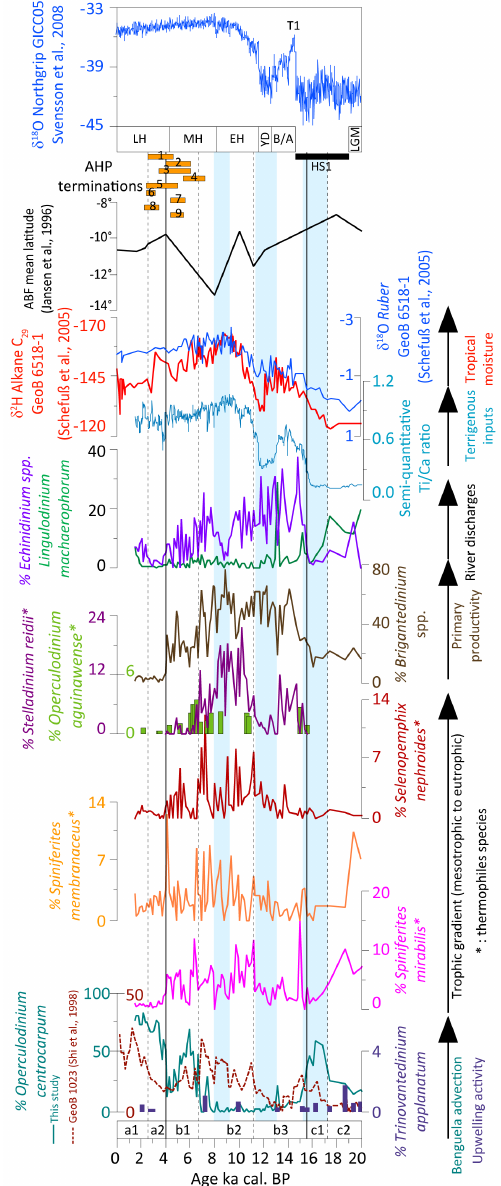
Figure 8. Temporal focus on the last 20kyr. Sea-surface temperature changes are discussed using major dinocyst species classified according to their trophic affinity: Spiniferites mirabilis , Spiniferites membranaceus , Selenopemphix nephroides and Stelladinium reidii . Sea-surface salinity changes are discussed using Echinidinium spp., Operculodinium aguinawense , Lingulodinium machaerophorum , in addition to stable isotopic signals from core GeoB6518-1 (Schefuß et al., 2005). Upwelling activity and Benguela Current activity are respectively discussed using, respectively, Trinovantedinium applanatum and Operculodinium centrocarpum percentages with the KZAI-01 core, together with the latitudinal location of the Angola–Benguela Front (Jansen et al., 1996) and O. Centrocarpum relative abundances acquired in the Benguela upwelling system on the GeoB1023 core (Shi et al., 1998). Higher primary productivity conditions in the study area are indirectly discussed using Brigantedinium spp. percentages. XRF Ti / Ca ratio obtained on the KZAI-01 core allows discussing past terrigenous supplies. NGRIP (NorthGrip ice-core) δ 18 O (GICC05 timescale; Svensson et al., 2008) is also displayed in parallel with the last deglaciation. Holocene (Walker et al., 2012) subdivisions: Last Glacial Maximum (LGM), Heinrich Stadial 1 (HS1), Bølling–Allerød (B/A), Younger Dryas (YD), early Holocene (EH), mid-Holocene (MH) and late Holocene (LH). Blue bands correspond to cold and dry events recorded with dinocyst assemblages. African Humid Period (AHP) terminations are also depicted according to the literature (orange bars): 1. Kröpelin et al. (2008); 2. Shanahan et al. (2015); 3. Hély et al. (2009); 4. Lézine et al. (2005); 5. Lebamba et al. (2012); 6. Lézine et al. (2013); 7. Tierney and deMenocal (2013); 8. Shanahan et al. (2012); 9. deMenocal et al. (2000). Palynozones subdivisions are also highlighted (aX, bX; cf. Figs. 4 and